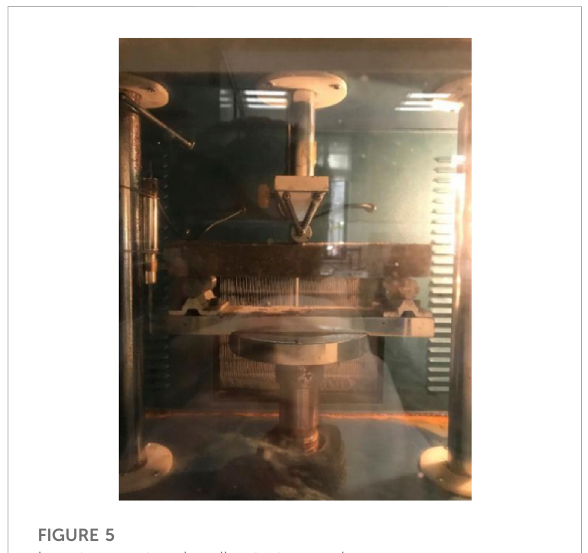
FIGURE 5 Low-temperature bending test